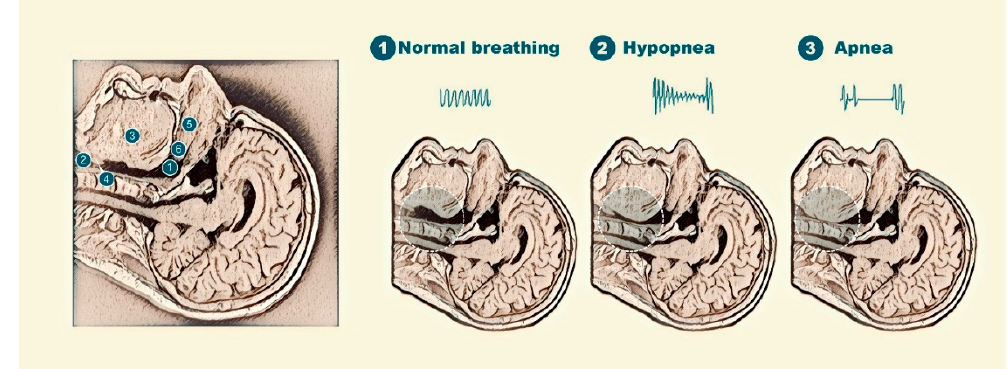
Figure 5. Image of the upper airway seen by magnetic resonance and its collapsibility in patients with OSA and anatomical description of the upper airway (left); representation of (1) normal breathing: 1: the pharynx; 2: the larynx; 3: the genioglossus muscle; 4: the epiglottis; 5: the hard palate; and 6: the soft palate; (2) partial upper airway obstruction; and (3) complete obstruction of the upper airway.